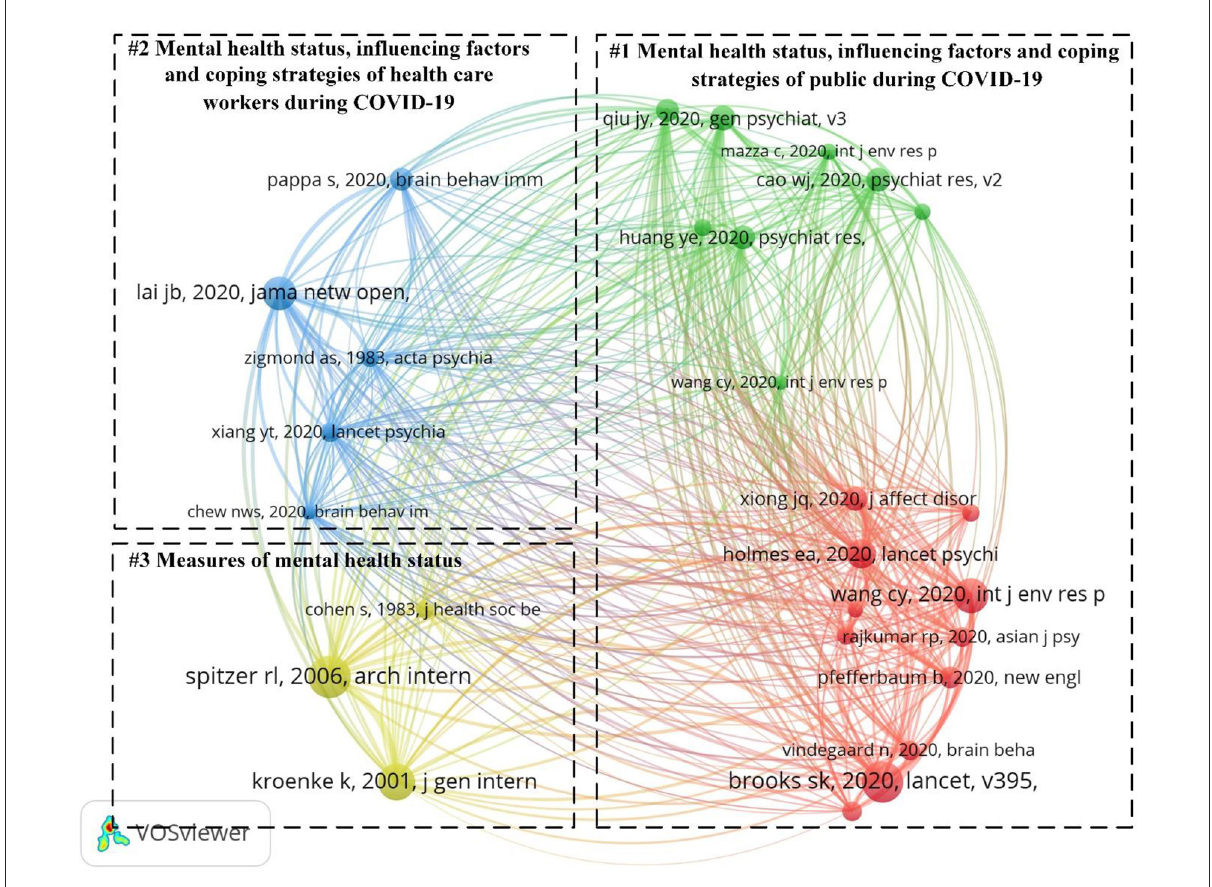
FIGURE6 Map of references network. The nodes represent cited literature. The lines represent co-citation relationships. The green and red represent “Mental health status, influencing factors, and coping strategies of the public during COVID-19.” The blue represents “Mental health status, influencing factors and coping strategies of health care workers during COVID-19.” The yellow represents “Measures of mental health status.”